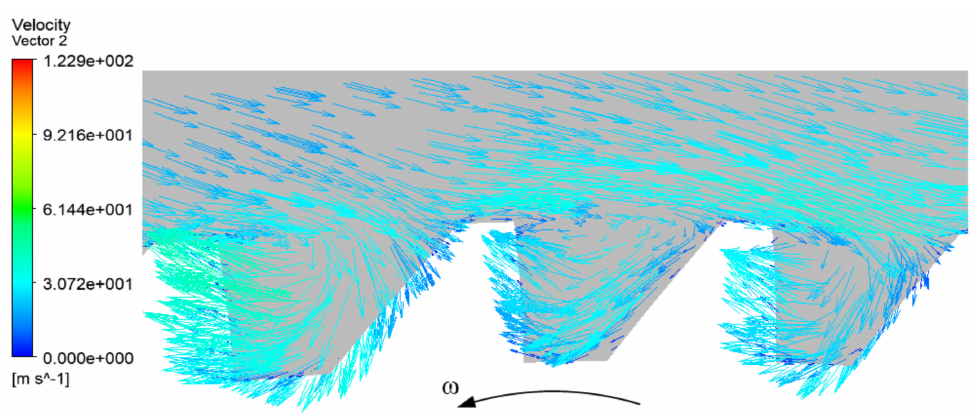
Figure 4. Velocity vector of fluid around